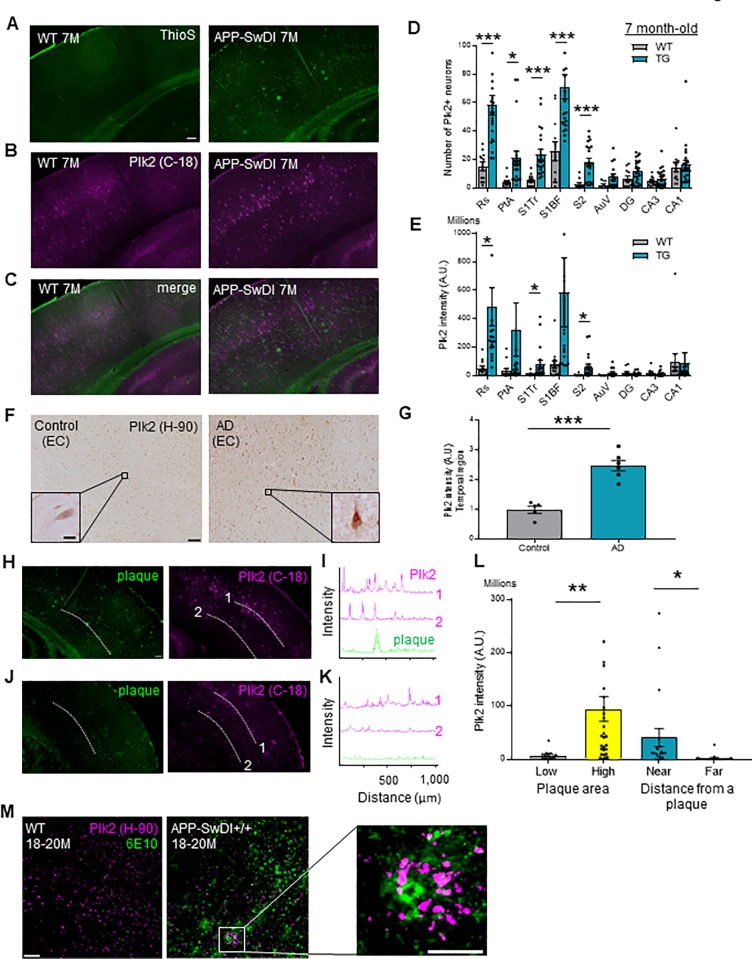
Plk2 upregulation in APP-SwDI and AD brain.(A-C) Representative sections of primary somatosensory cortex from 7-month-old WT C57BL/6 or APP-SwDI+/+ mice as indicated, stained with thioflavin S (A) and immunolabeled with Plk2 antibody (C-terminal epitope) C-18 (B), with merge in (C). Scale, 100 μm. (D, E) Number of Plk2 expressing neurons (Rs: t (31) = 4.289, p = 0.0002; PtA: t (31) = 2.699, p = 0.0112; S1Tr: t (31) = 3.811, p = 0.0006; S1BF: t (31) = 3.689, p = 0.0009; S2: t (29) = 3.805, p = 0.0007) (D) and Plk2 integrated intensity (Rs: t (29) = 2.551, p = 0.0163; S1Tr: t (30) = 2.112, p = 0.0431; S2: t (27) = 2.081, p = 0.0471) (E) at 7 months in WT and APP-SwDI+/+ transgenic (TG) mice (n = 9–22 regions from 6 animals); all statistical comparisons are between WT and TG per region (see S1D Fig for schematic of regions analyzed). (F) Representative sections of post-mortem human entorhinal cortex (EC) from non-demented control and age matched AD patients as indicated, immunolabeled with Plk2 antibody H-90. Scale bars, 100 μm (wide field), 10 μm (inset). (G) Quantification of Plk2 intensity in temporal regions (hippocampus and EC) (n = 5 cases for control and n = 6 for AD; t (9) = 6.491, p = 0.0001). (H, J) Representative thioflavin S and Plk2 staining in plaque-rich (H) and plaque-lacking (J) areas. (I, K) Line scans of indicated lamina from H, J. (L) Left bars, Plk2 integrated intensity per 400 μm-width cortical subdivision region of interest containing <1000 μm2 visible plaque area (low: n = 16 regions from 6 animals per genotype) or >1000 μm2 visible plaque area (high: n = 29; low vs high: t (43) = 2.737, p = 0.0090). Right bars, Plk2 intensity measured <100 μm (near; n = 20) and >400 μm (far; n = 17; near vs far: t (35) = 2.119, p = 0.0412) from plaques. (M) Representative sections of primary somatosensory cortex in WT and APP-SwDI+/+ mice at 18–20 months co-immunolabeled with 6E10 for plaque staining and Plk2 H-90. Right, magnified view of boxed area. Scale bars, 50 μm (wide field), 10 μm (higher magnification). ***p < 0.001, **p < 0.01, *p < 0.05; two-tailed unpaired Student’s t-test. Data are means± SEM. Experiments were performed in at least duplicate.